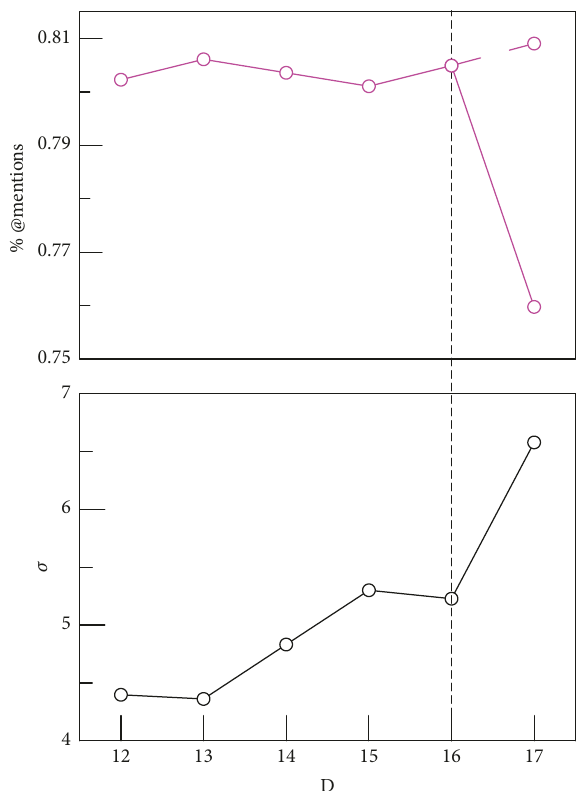
Figure 9: Evolution of the percentage of mentions (top) and the heterogeneity index, 𝜎 , (bottom) for the retweet networks starting on December 11th until day D of 2017 Chilean Presidential elections. Intoppanel,thedottedlinecorrespondingtotheelectoralcampaign period 11-17 December 2017 without taking into account the users who only participate on the voting